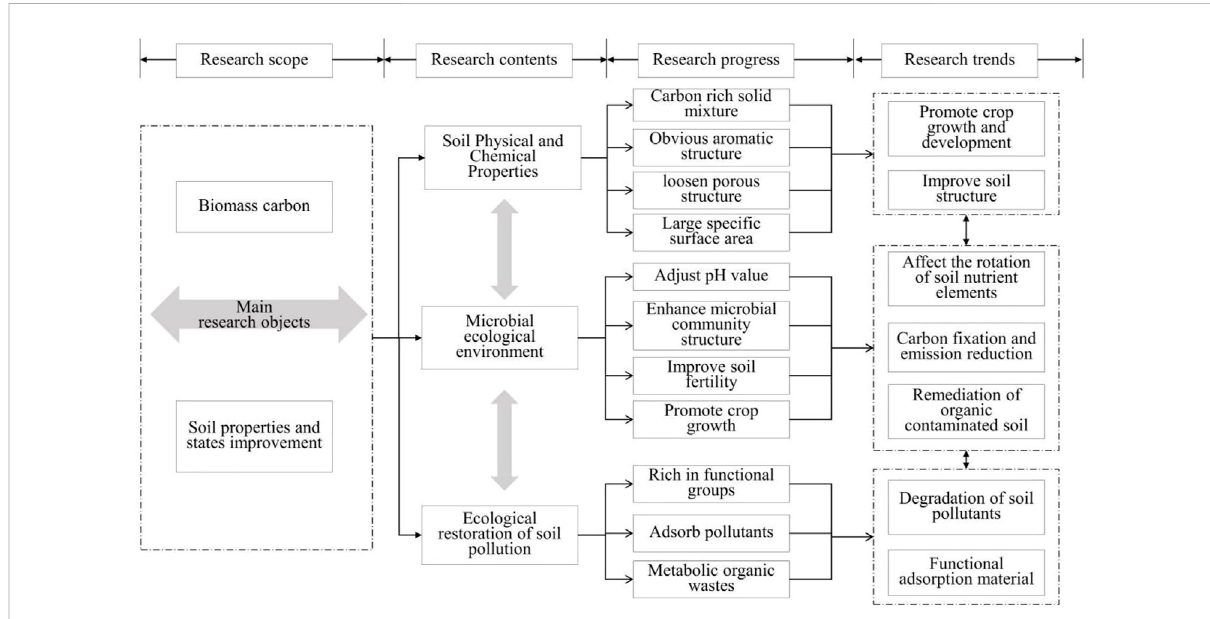
FIGURE 1 Research progress on improving rural soil properties by biomass